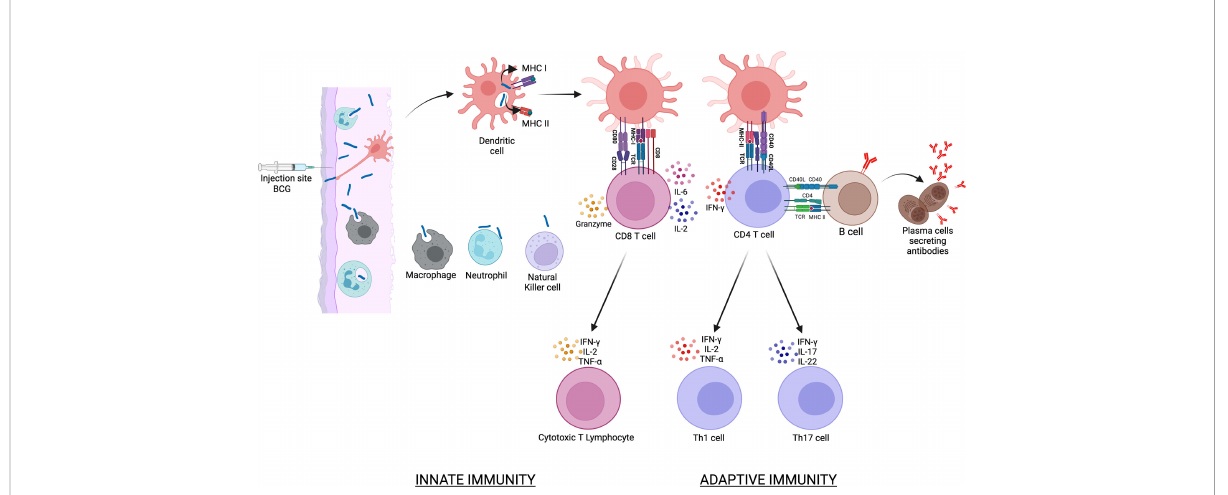
FIGURE 1 illustrates the events that follow the intradermal injection of BCG. BCG is phagocytosed by various cells of the innate immune response that includes dendritic cells, macrophages and neutrophils. Dendritic cells are the main antigen presenting cells and BCG antigens are presented to CD4 via the MHC class II molecules and to CD8 T cells via the MHC class I molecules. This is followed by the activation of B cells, cytotoxic T lymphocytes and Th17 cells that collectively constitute the adaptive immune response to BCG